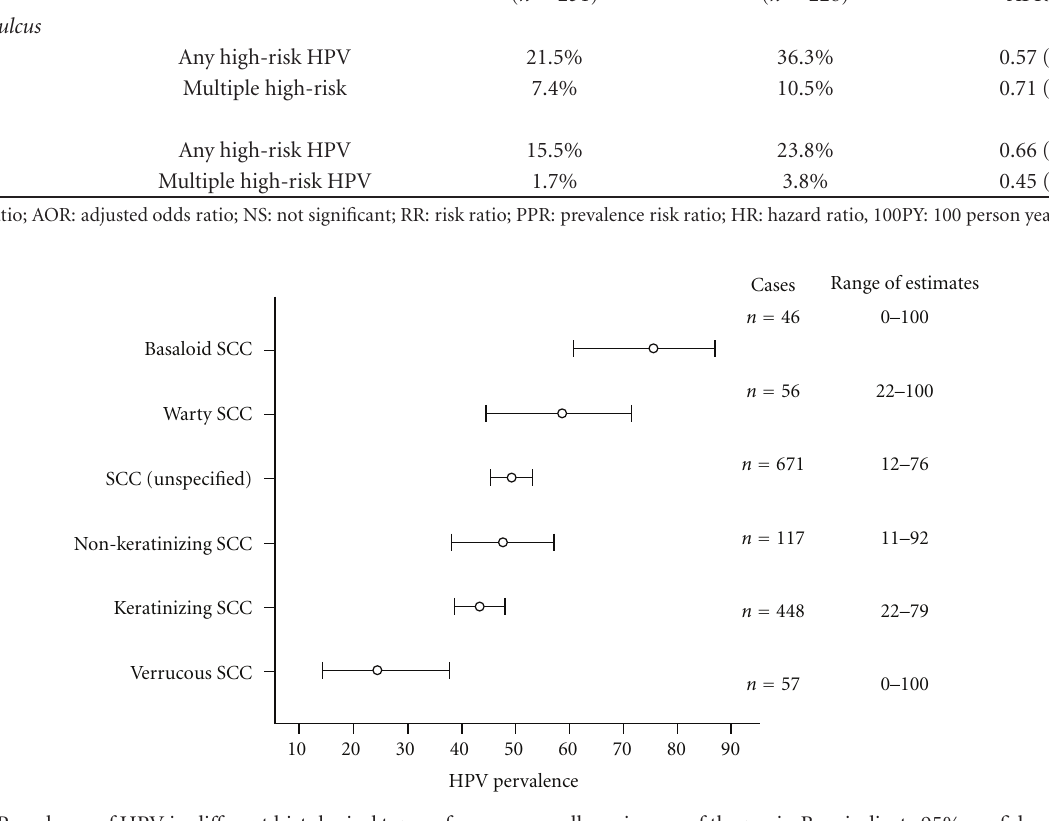
Figure 1: Prevalence of HPV in di ff erent histological types of squamous cell carcinoma of the penis. Bars indicate 95% confidence intervals. Modified from Miralles-Guri et al.